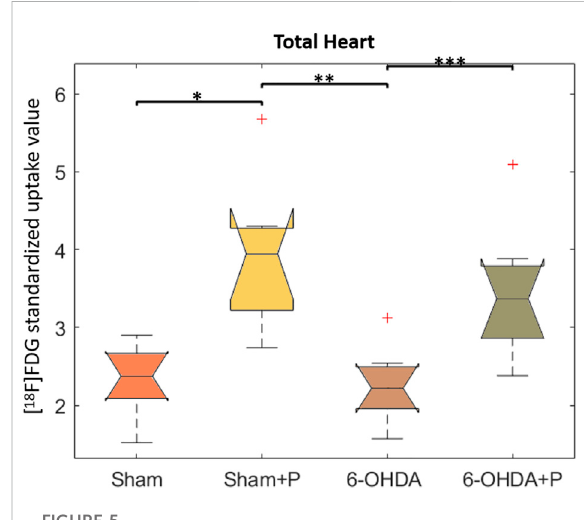
FIGURE 5 Standardized [18F]FDG uptake value in left